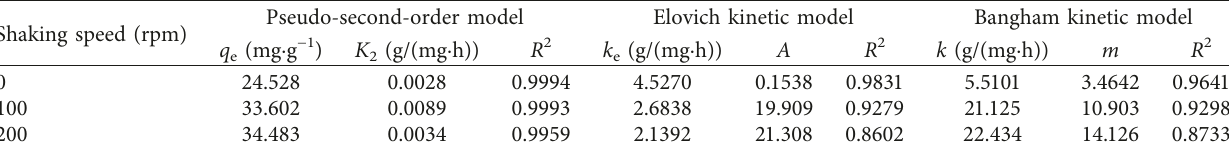
Table 6: Kinetic parameters of adsorption using pseudo-second-order model, Elovich kinetic model, and Bangham kinetic model.